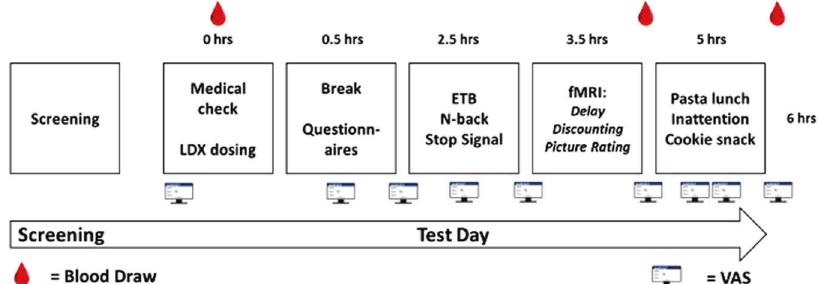
Fig. 1 Timeline of screening and testing. Flow diagram showing an overview of the screening and test days timings in hours